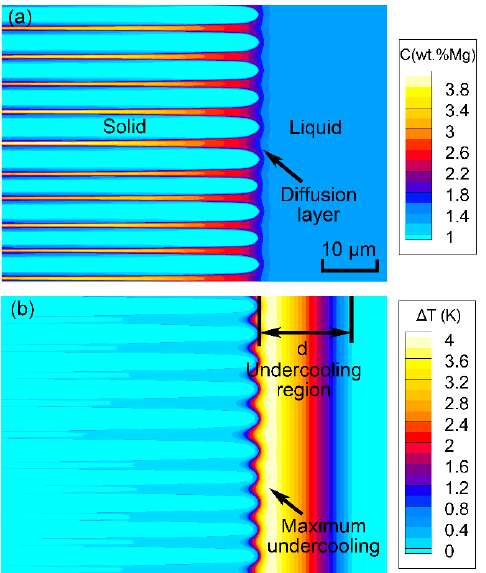
Figure 6. Contour plot of ( a ) solute distribution and ( b ) constitutional undercooling distribution for solidification conditions G = 300 K/mm and V p = 3 mm/s.